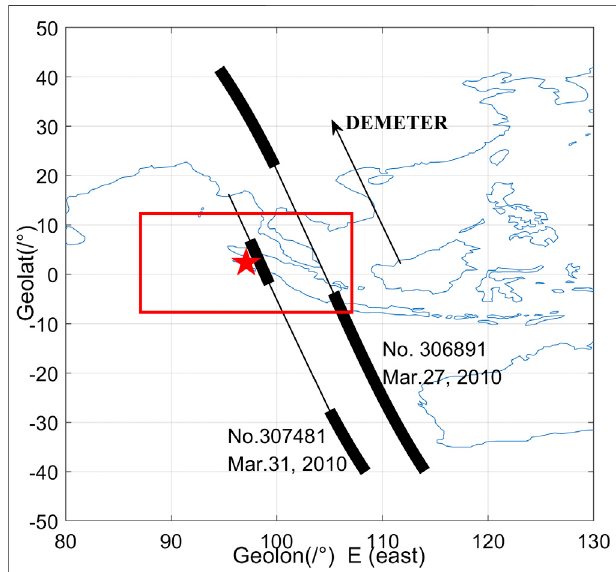
FIGURE 6 | The available waveform data (thick lines) recorded by burst- mode observations near the seismic zone. The red rectangle is the area of